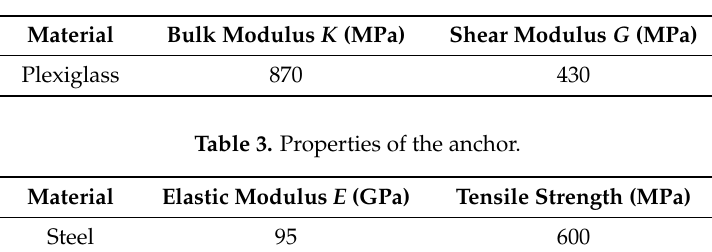
Table 2. Properties of the inclinometer and retaining wall.